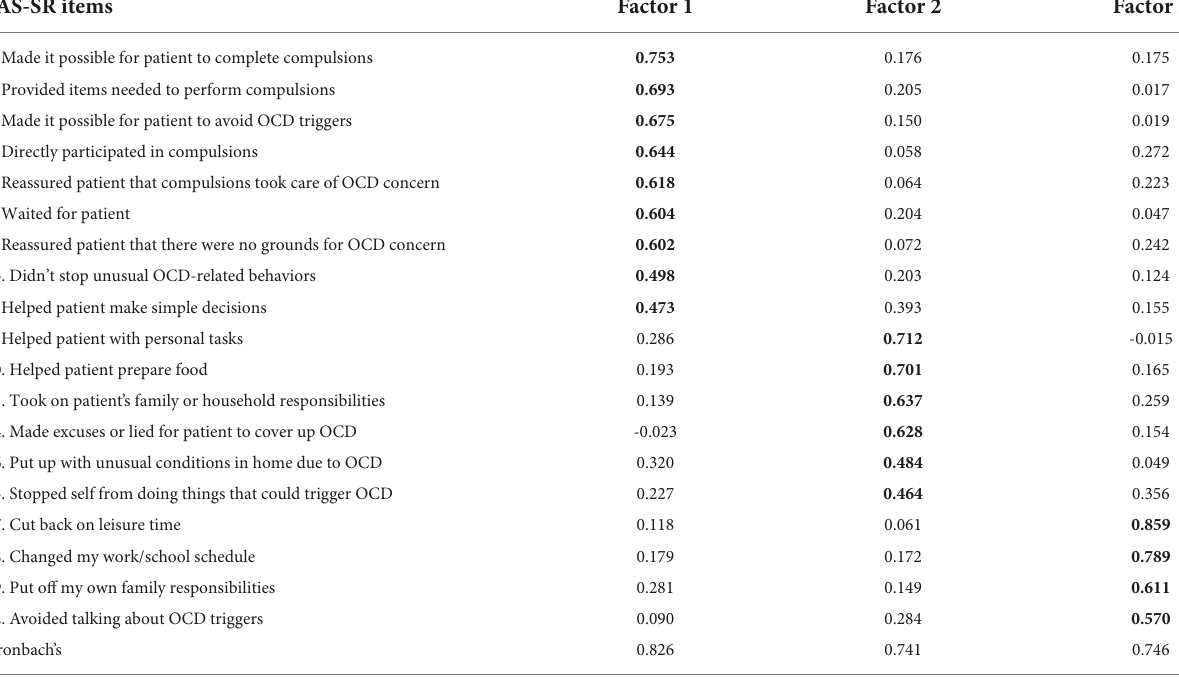
TABLE 4 Exploratory factor analysis of the Chinese version of the FAS-SR. FAS-SR items